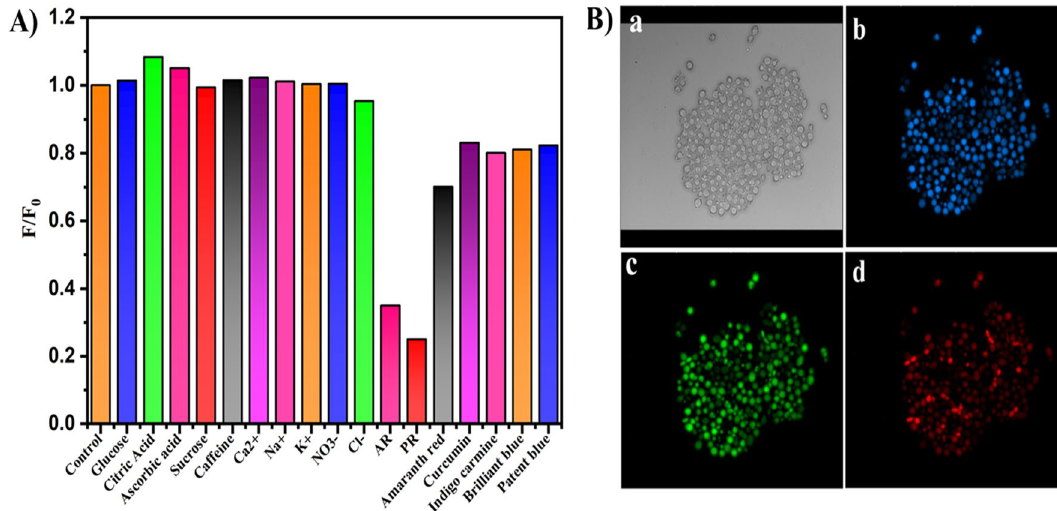
Figure 5. ( A ) Study of effect of interfering ions and molecules on fluorescence quenching of CDs ( B ) Confocal laser microscopic images of S. cerevisiae treated with CDs in bright field ( a ), and at excitation wavelengths ( b ) 408 (blue), ( c ) 488 (green), and ( d ) 561 (red) nm.